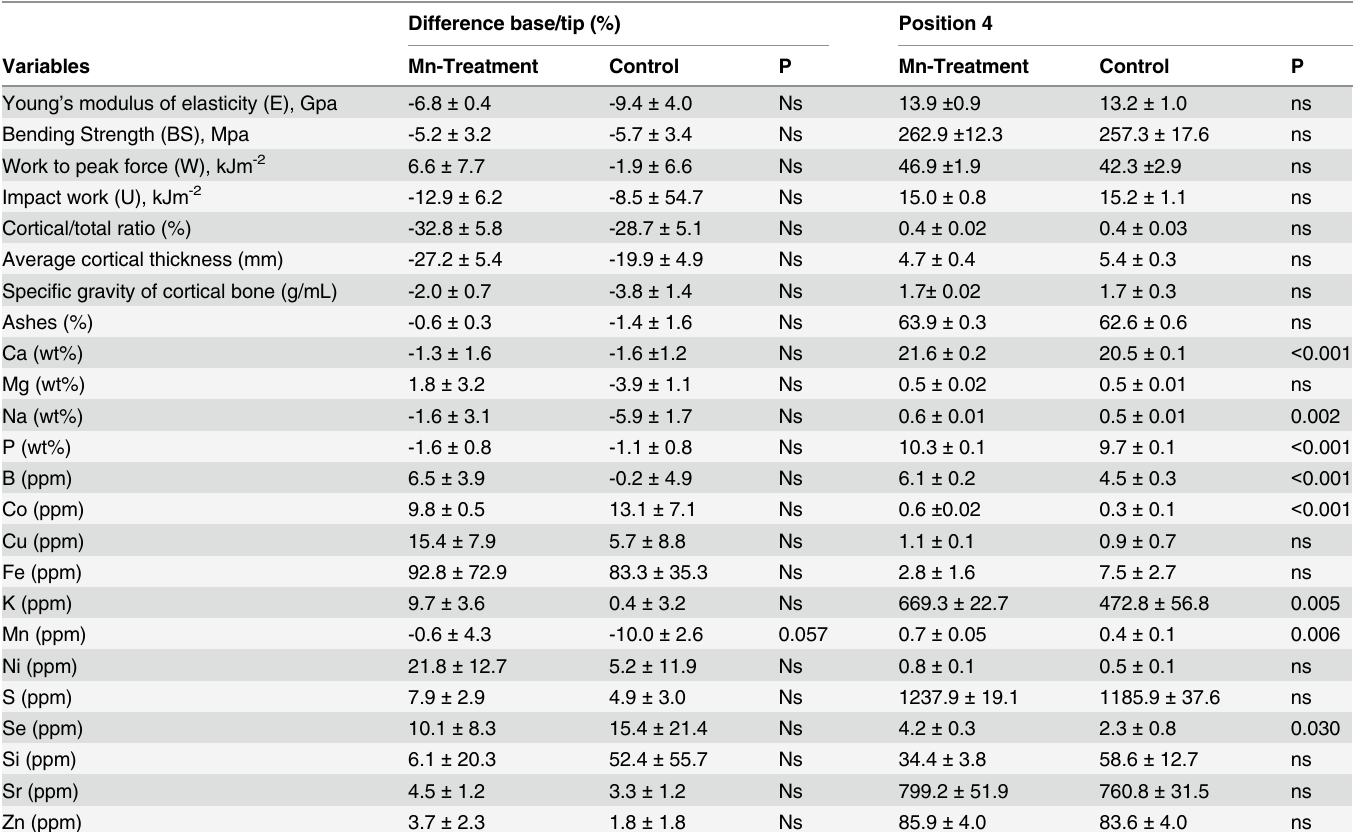
Table 3. Mean ± SE differences between the basal position ( Position 1 ) and the distal position ( Position 4 ) in percentage, in adult red deer injected (Mn-Treatment) or not (Control) with manganese as a nutrient supplement. A decrease from base to top is shown as a negative value. The right half of the table shows the mean ± SE for position 4 (the uppermost showing most clearly physiological exhaustion and depletion of body stores). Differences and probabilities are shown on the basis of one-way